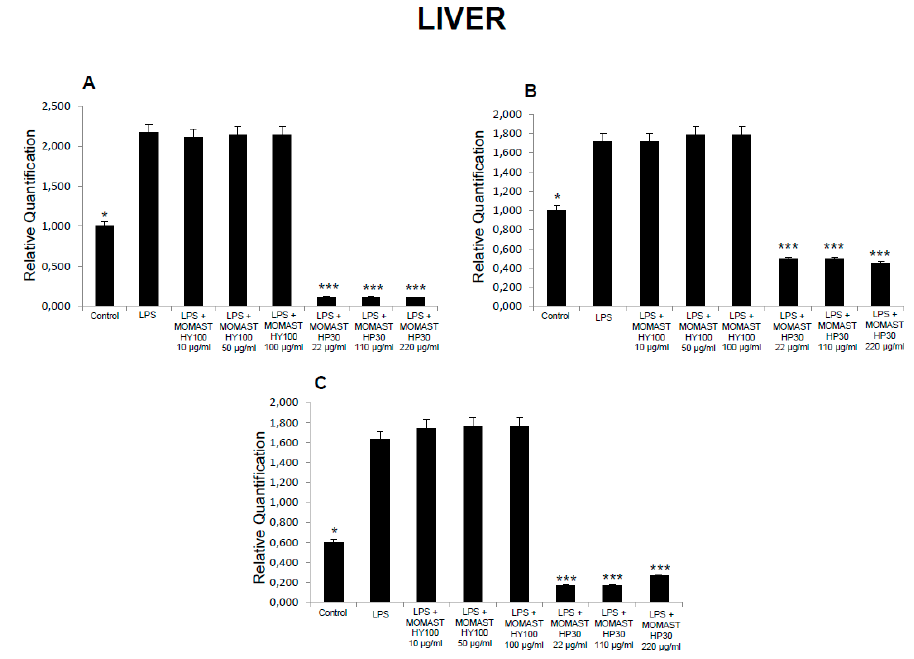
Figure 7. Effects of MOMAST( ® ) HY100 (10, 50, and 100 µg/mL) and MOMAST( ® ) HP30 (22, 110, and 220 µg/mL) on ( A ) cyclooxygenase (COX)-2, ( B ) tumor necrosis factor α (TNF α ), and ( C ) inducible nitric oxide synthase (iNOS) in rat liver specimens. Data were reported as means ± SEM. ANOVA, p < 0.01; post-hoc test, * p < 0.05, *** p < 0.001 vs. LPS-treated group. Moreover, MOMAST (®) HY100 (10, 50, and 100 µg/mL) was effective in inhibiting LPS-induced